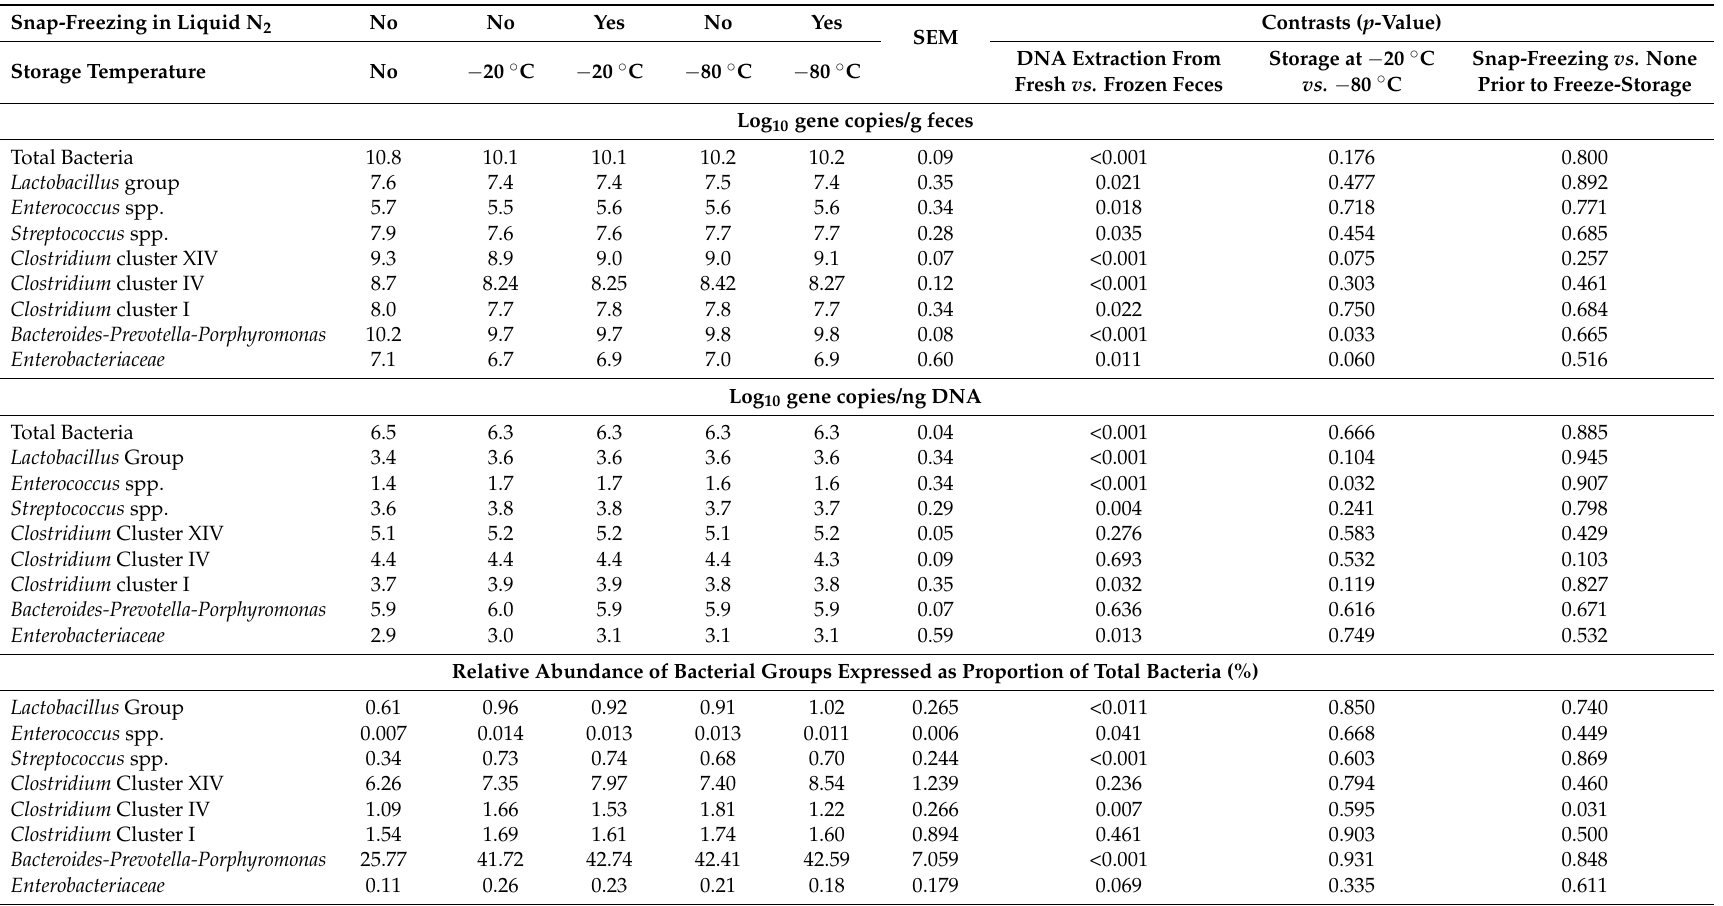
Table 1. Effect of freezing condition on bacterial composition in pig feces